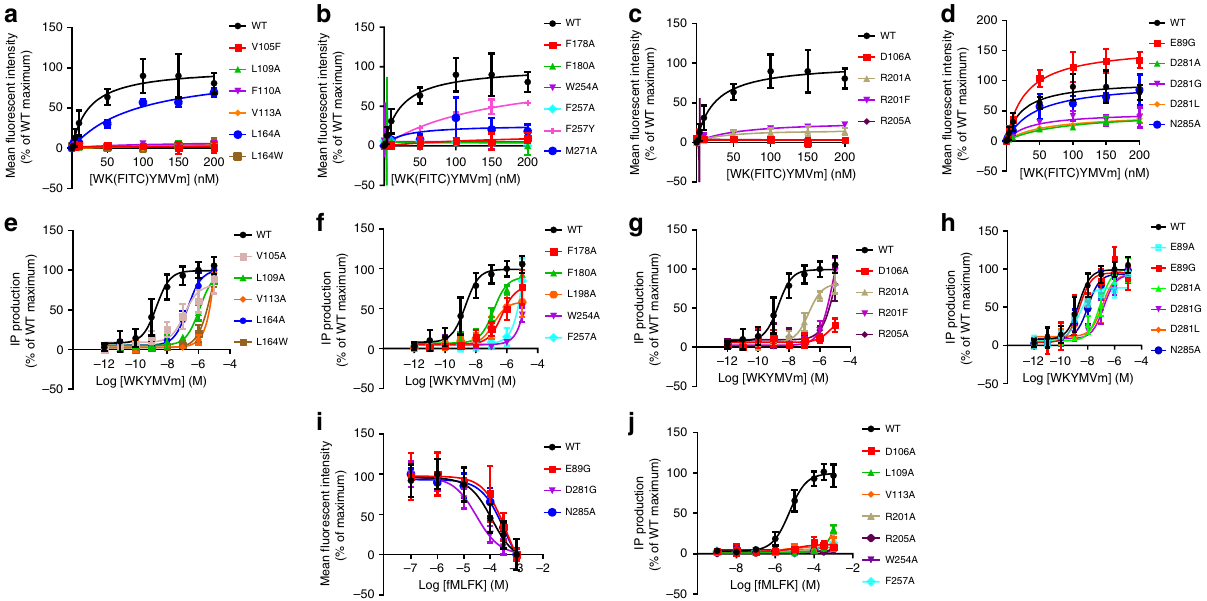
Fig. 4 Ligand binding and signaling assays of the wild-type (WT) FPR2 and mutants. Dose – response curves were generated from at least three independent experiments performed in triplicate. Data are shown as mean ± s.e.m. Source data are provided as a Source Data fi le. a – d Saturation binding of WK(FITC)YMVm. See Supplementary Table 1 for detailed statistical evaluation. e – h WKYMVm-induced IP accumulation assay using a chimeric G α protein G α Δ 6qi4myr . See Supplementary Table 2 for detailed statistical evaluation. i Binding of WK(FITC)YMVm inhibited by fMLFK. See Supplementary Table 1 for detailed statistical evaluation. j fMLFK-induced IP accumulation assay. See Supplementary Table 2 for detailed statistical